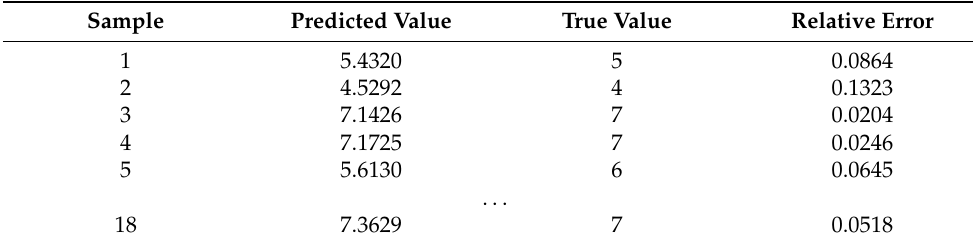
Table 6. The predicted value is compared with the actual